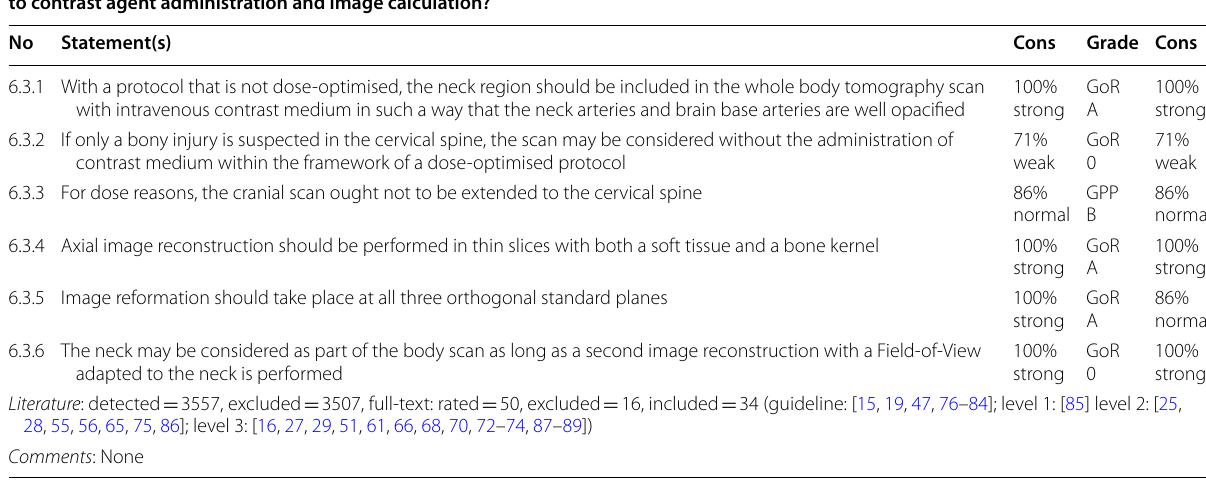
Table 12 Section 6: Whole Body CT – Protocol, key issue 3: Cervical Neck/Spine How should the head/neck region in the standard whole-body tomography protocol be performed in a polytrauma patient with regard to contrast agent administration and image